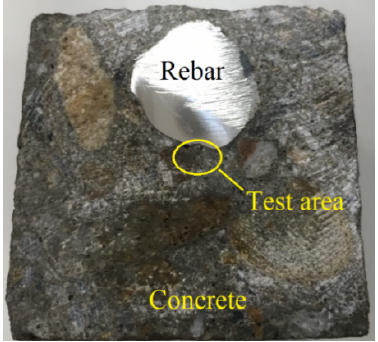
Figure 1. Vickers hardness test section of cube specimen.